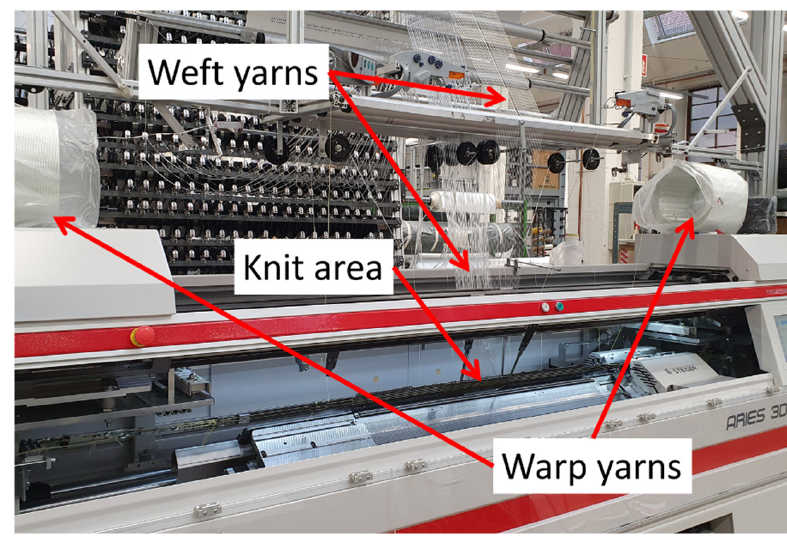
Figure 4. Modified Steiger Aries.3 ® flat knitting machine.